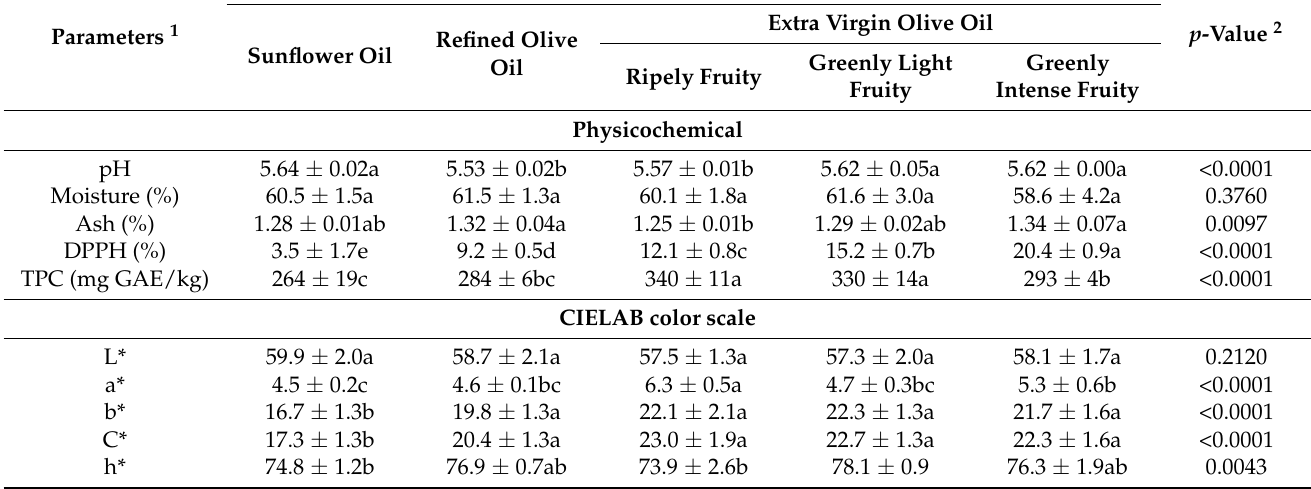
Table 3. Mean values ( ± standard deviation) of pH, moisture (%), ash (%), DPPH (%), total phe- nols contents (TPC mg GAE/kg), and color of canned tuna covered with different oil media (n = 5 cans × 3